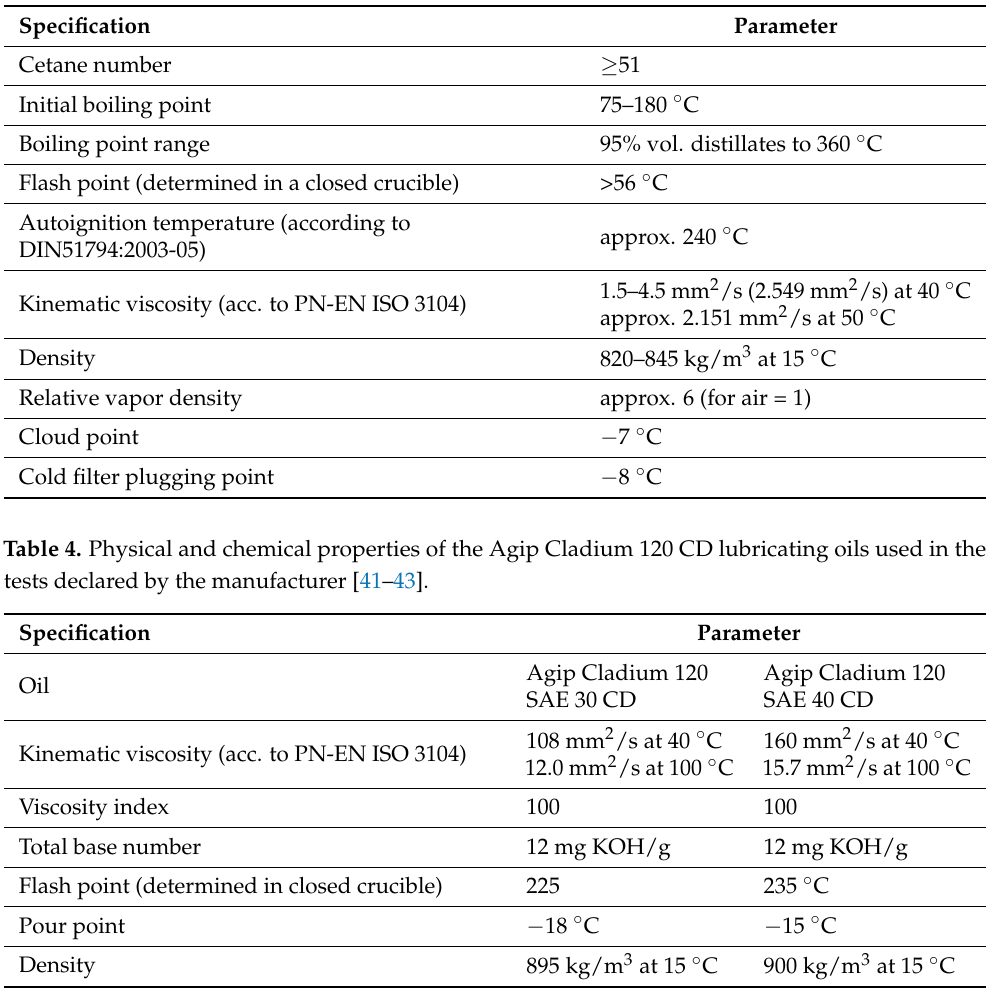
Table 3. Physical and chemical properties of Orlen Efecta Diesel Biofuel declared by the manufacturer [40].